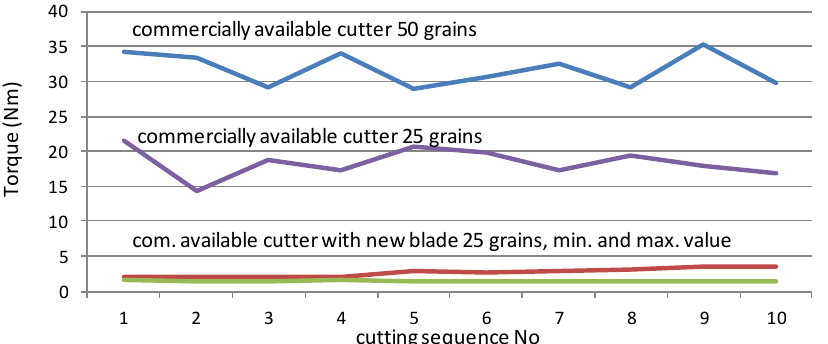
Figure 18. Torque values obtained by measuring of the manual force on the commercial and new knife.